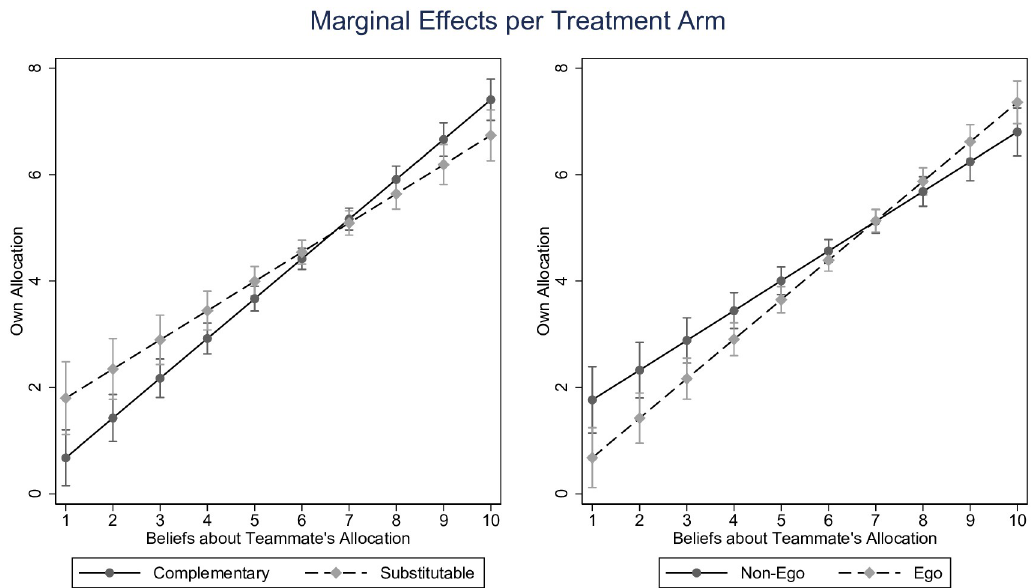
Fig 4. Participants’ contribution decision as a function of the beliefs about teammate’s contribution. Error bars show 95% confidence intervals.